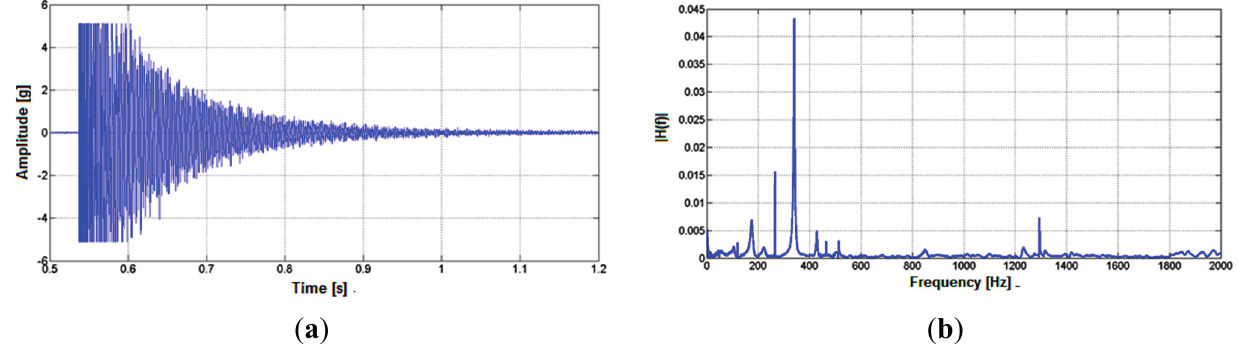
Figure 11. Vibration test: dynamic behavior in the ( a ) time and ( b ) frequency